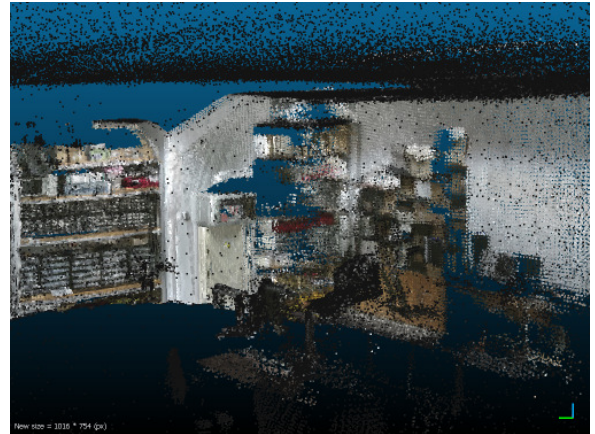
Figure 4. RTABMAP model of our